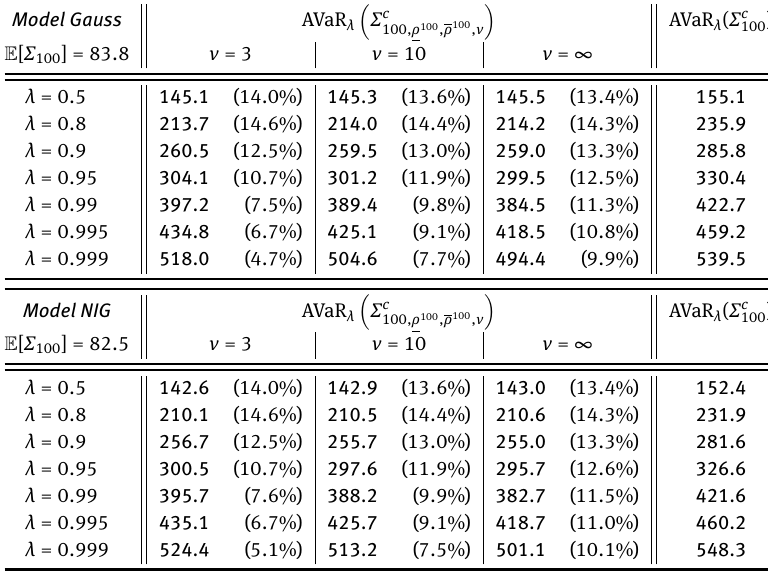
) ) with the standard comonotonic risk bound AVaR ( Σ c 100 λ 100, ρ 100 , ρ 100 , ν ( Σ c ) − E [ Σ 100 ])/(AVaR ( Σ c ) − 100 λ λ 100, ρ 100 , ρ 100 , ν